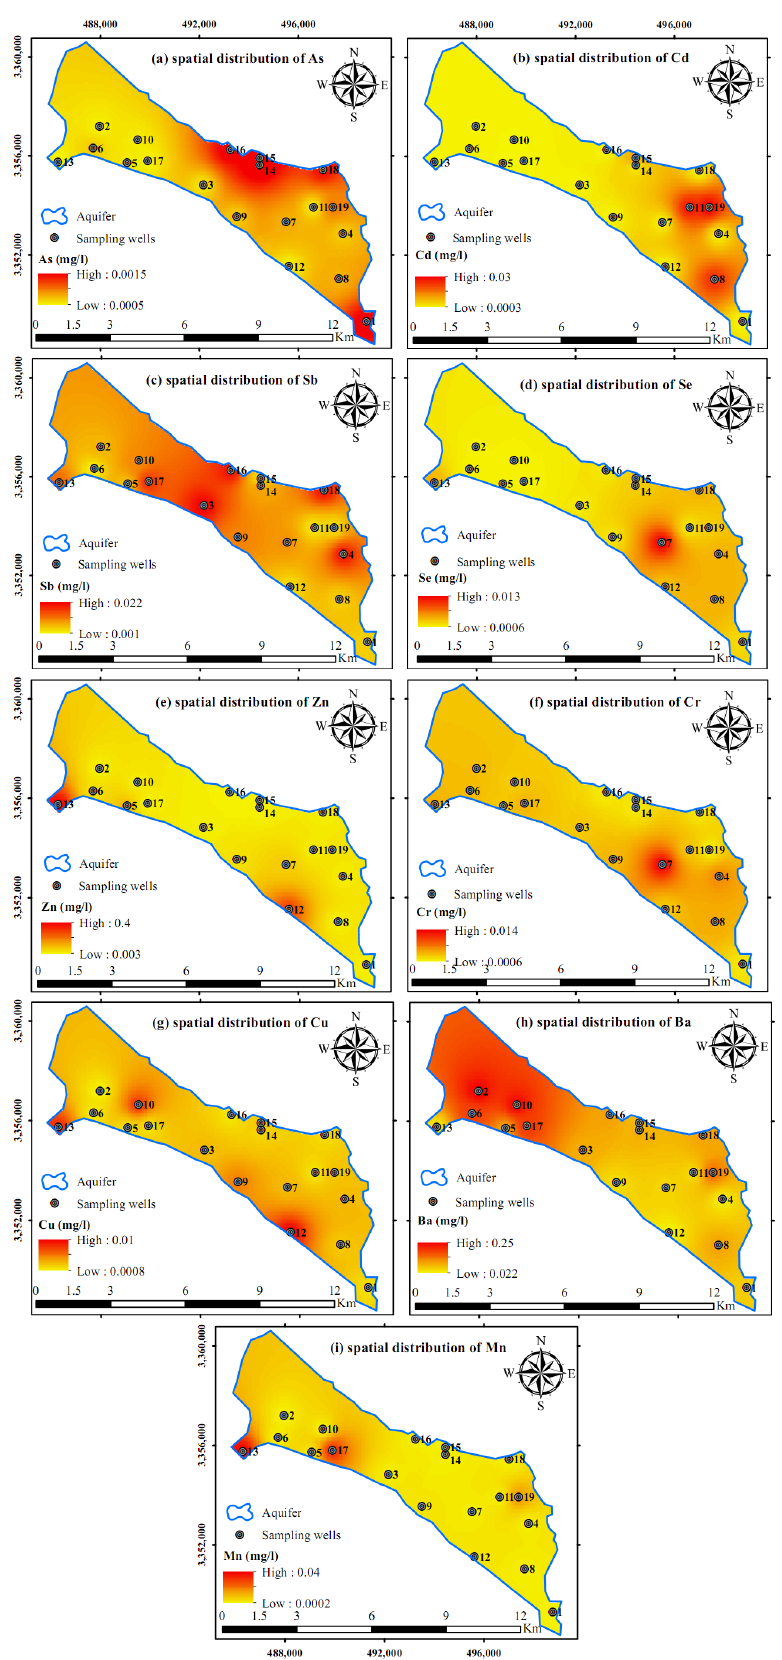
Figure 9. Spatial distribution of heavy metals for samples collected in the study area.